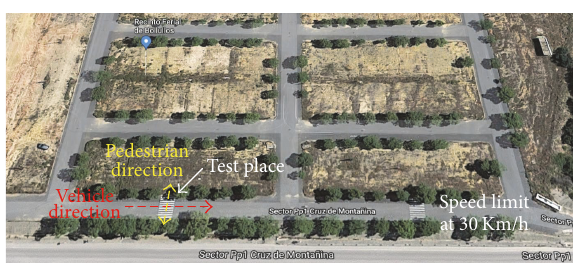
Figure 14: Location of the scenario under